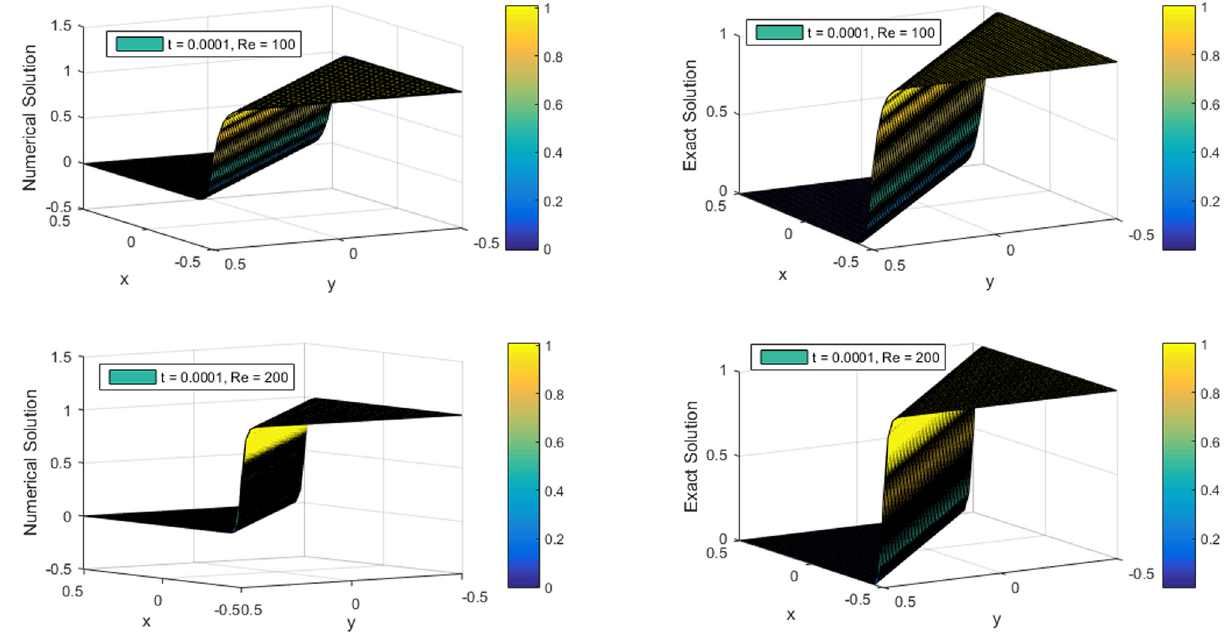
Figure 12: Comparability of fetched and exact solutions at = t 0.0001 for = Re 100 and 200.